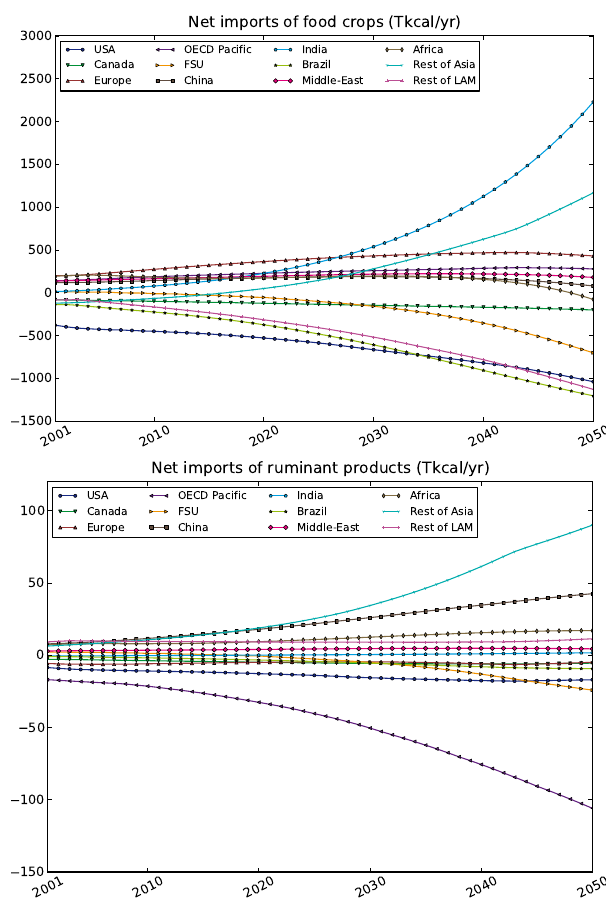
Fig. 17. Net imports of food crops (top), and ruminant products (bottom) resulting from the sample output run. 1 Tera kilo calorie (10 12 kcal) = 4.1868Peta Joules (10 15